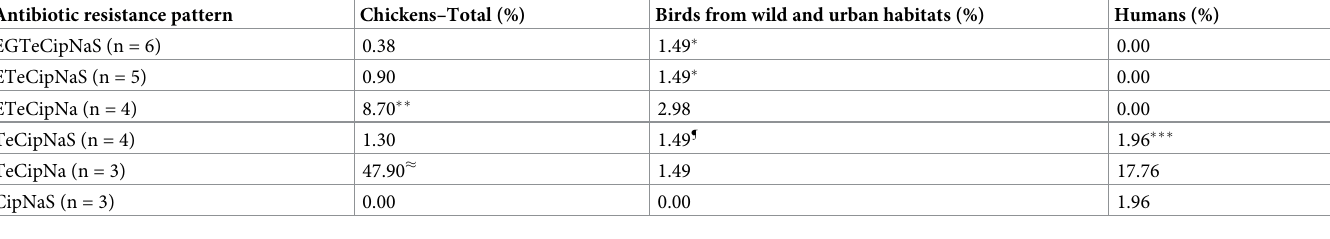
Table 3. Percentage of antimicrobial multi-resistance patterns among C . jejuni from chickens, birds from wild and urban habitats and humans. Antibiotic resistance pattern